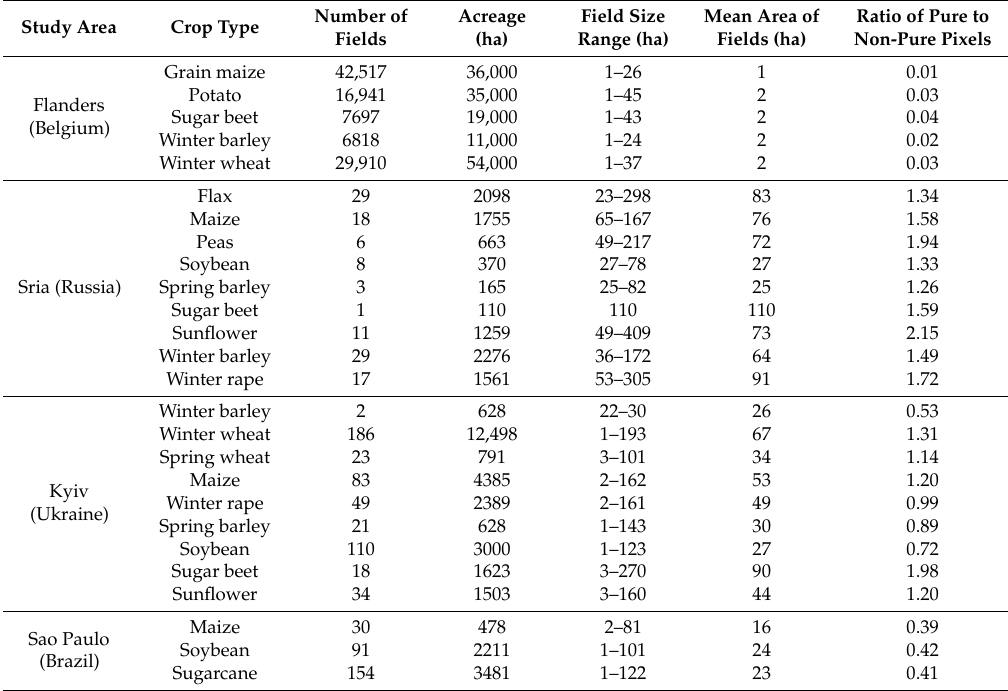
Table 2. Crop cover characteristics of the study